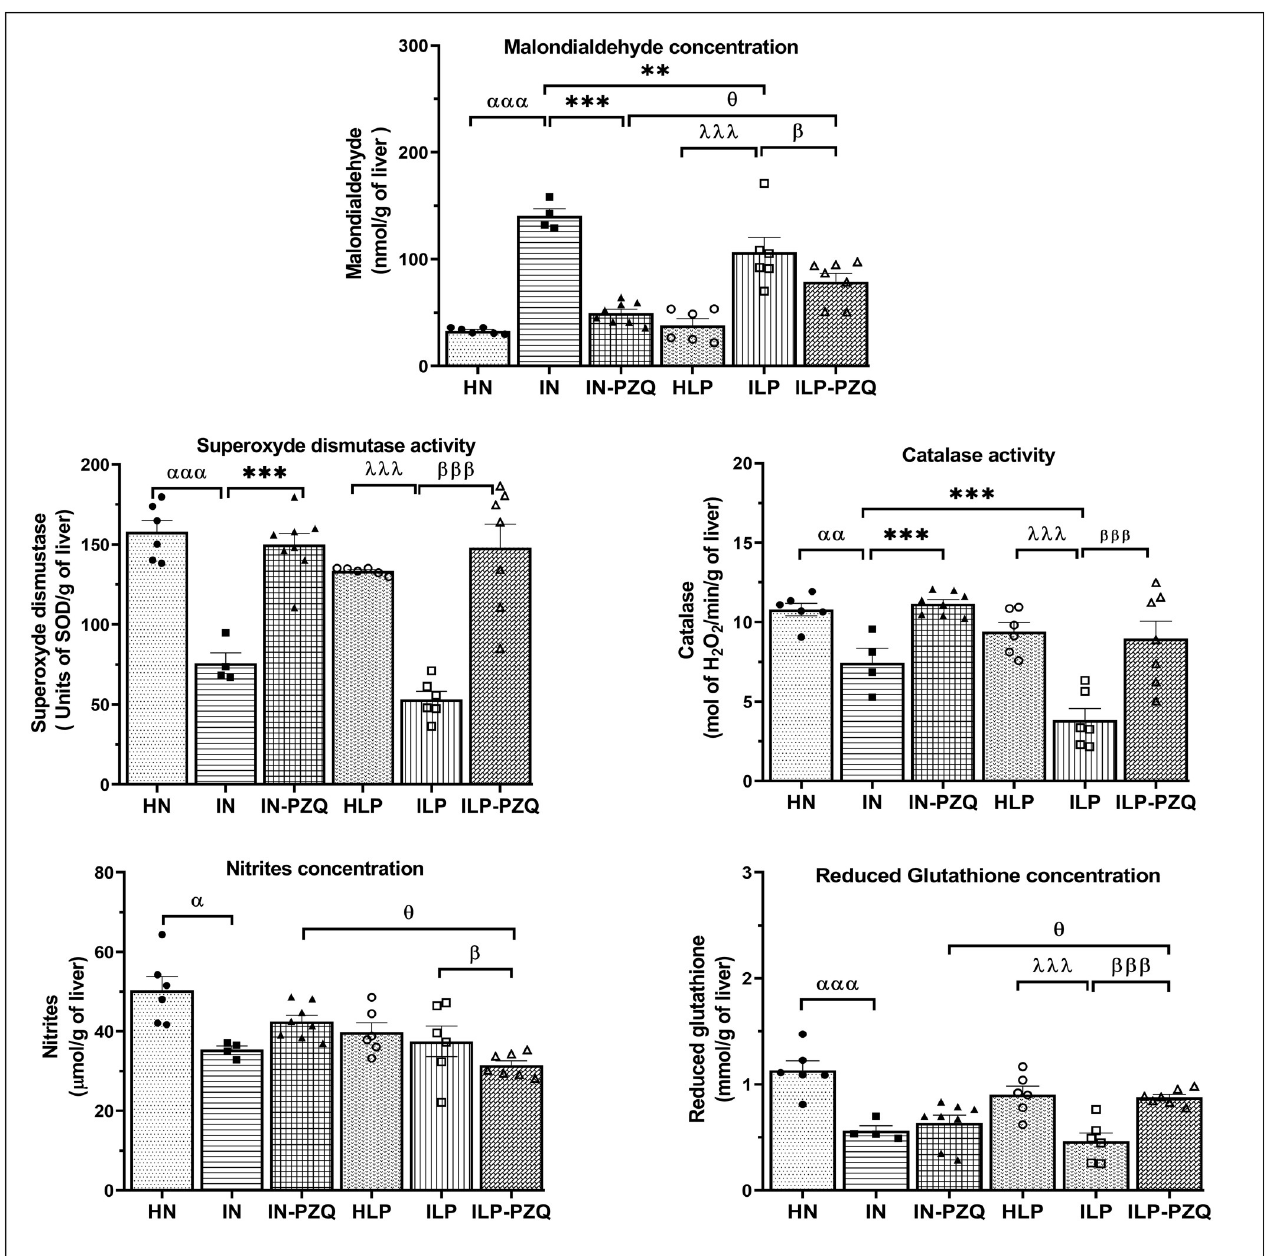
Fig 7. Effects of praziquantel treatment on the liver oxidative stress biomarkers of Schistosoma mansoni -infected mice receiving a low-protein diet. Data are expressed as mean ± SEM (n = 4–8). Group HN: healthy mice receiving a standard diet; group IN: infected-untreated mice receiving a standard diet; group IN-PZQ: infected mice receiving a standard diet and treated with praziquantel; group HLP: healthy mice receiving a low-protein diet; group ILP: infected- untreated mice receiving a low-protein diet; group ILP-PZQ: infected mice receiving a low-protein diet and treated with praziquantel. ANOVA followed by Turkey multiple comparison test. α P < 0.05; αα P < 0.01; ααα P < 0.001: values are significantly different from healthy mice receiving a standard diet (group HN). �� P < 0.01; ��� P < 0.001: values are significantly different from infected-untreated mice receiving a standard diet (group IN). λλλ P < 0.001: values are significantly different from healthy mice received a low-protein diet (group HLP). β P < 0.05; βββ P < 0.001: values are significantly different from infected- untreated mice receiving a low-protein diet (group ILP). θ P < 0.05: values significantly different from infected mice receiving a standard diet and treated with praziquantel at the dose of 100 mg/kg for 5 consecutive days (group IN-PZQ).